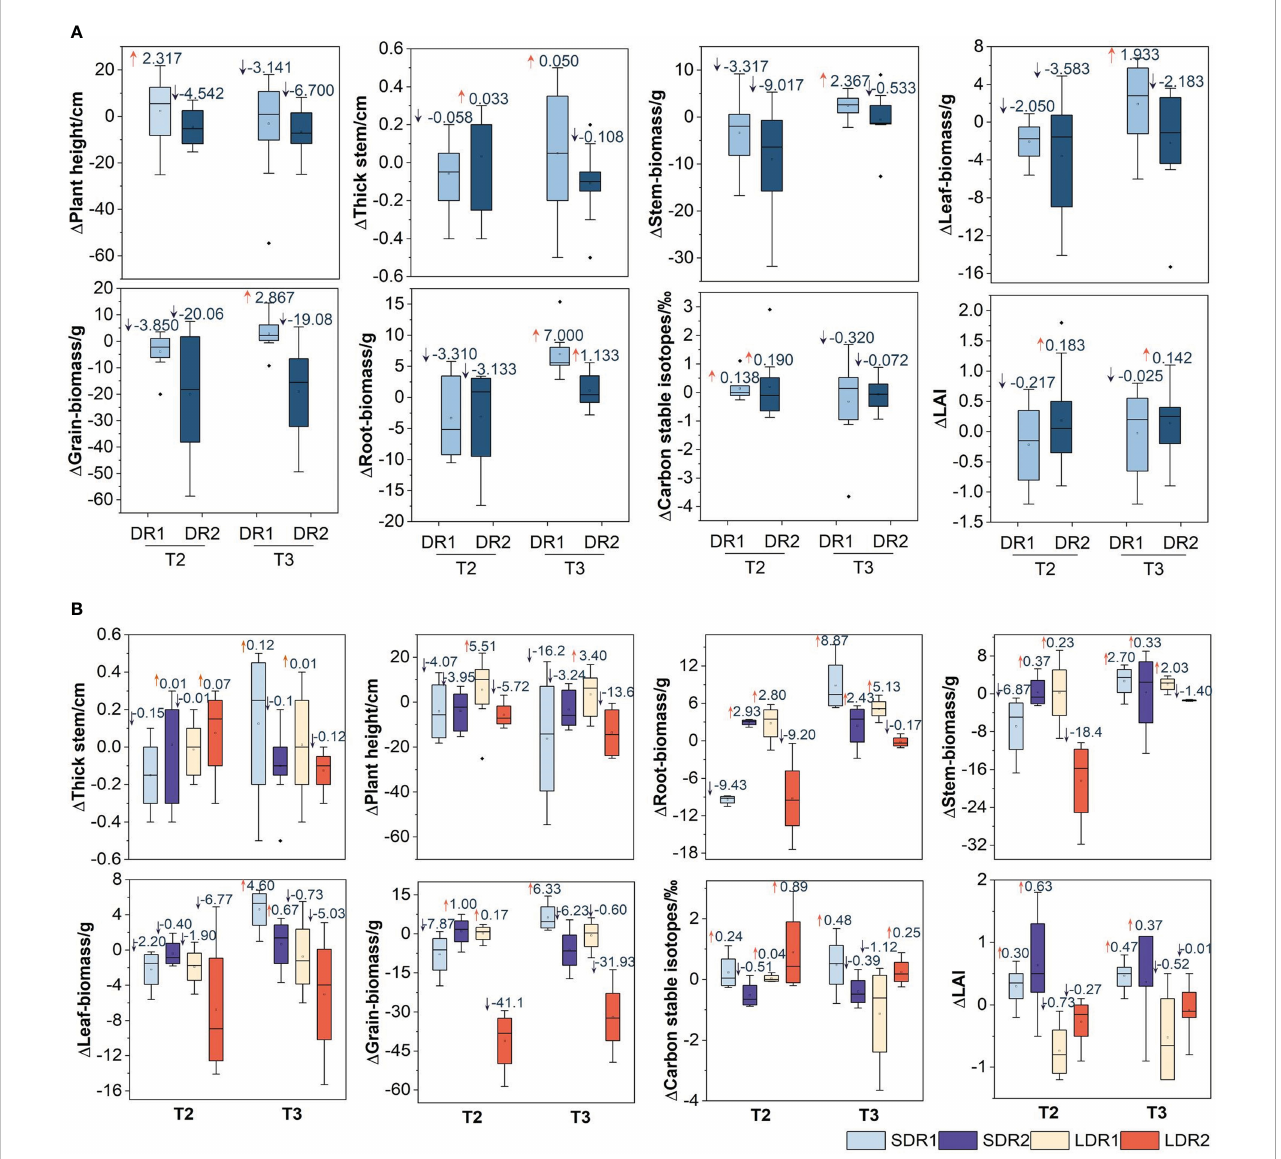
FIGURE 3 Effects of different (A) drought degree and (B) drought duration in the T2-T3 period on growth indexes of summer maize. in fi lling. SDR1, Short duration light drought (5 days); LDR1, Long duration light drought (7 days); SDR2, Short duration moderate drought (14 days); LDR2, Long-duration moderate drought (24